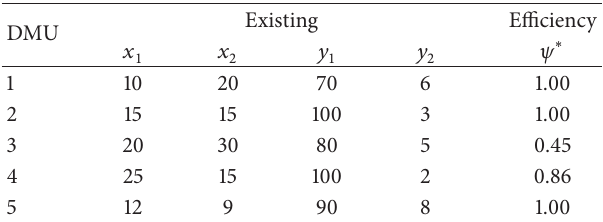
Table 2: The Data and Results Obtained from Model (3) with Two- Input and